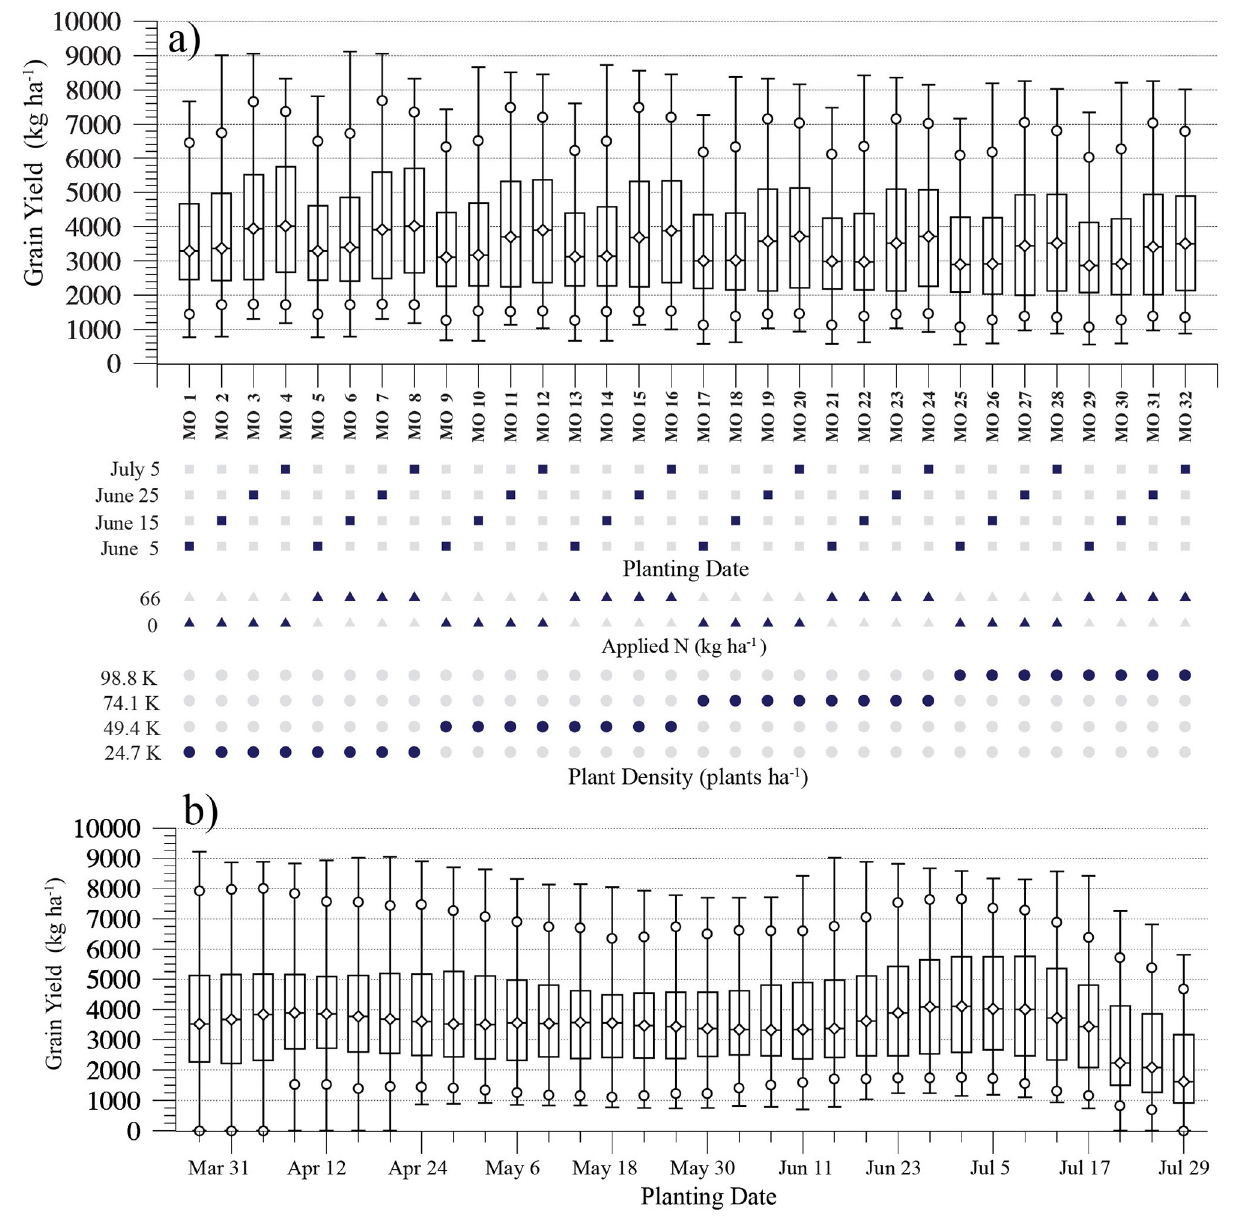
FIGURE 3 | (a) Percentiles of simulated grain yields for Table 1 ’s 32 management options, each aggregated over the 21 station’s simulations during the 11 years of 2005–2010 and 2012–2016 (231 yields). (b) Percentiles of simulated grain yields for MO 4 plant density and applied N, for March 27th to July 29th planting dates at 4 day